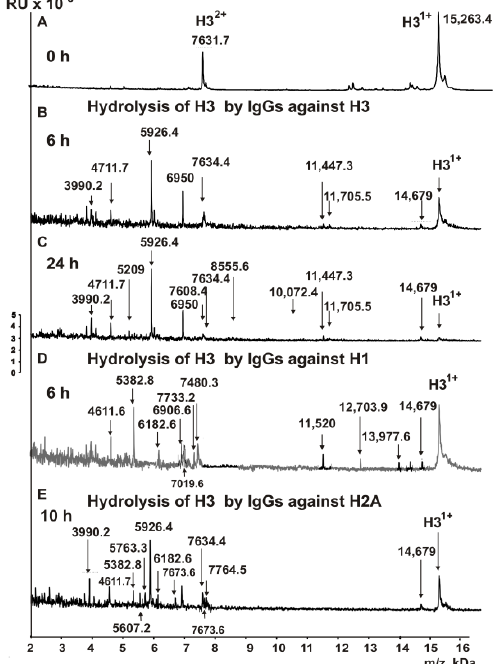
Figure 1. MALDI mass spectra corresponding to the H3 histone (0.8 mg/mL) over the time of hydrolysis (0–24 h) in the presence of different IgGs (0.045 mg/mL) against H3 ( A – C ), H1 ( D ), and H2A ( E ). All of the used antibody preparations and the molecular masses (m/z, Da) of the products are indicated on Panels A – E; RU — relative units.